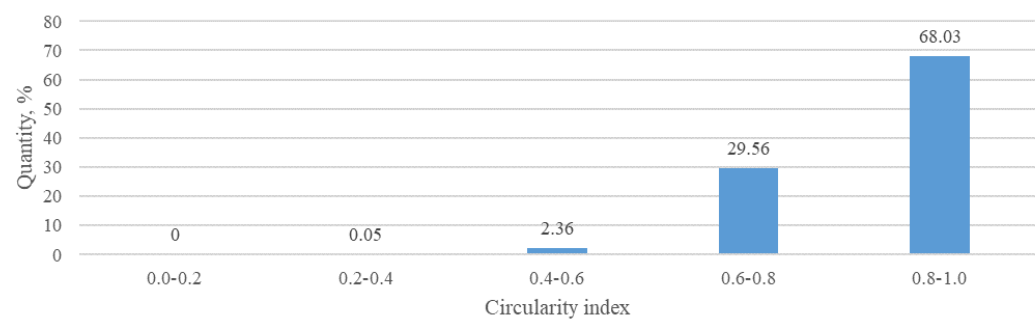
Appl. Sci. 2020 , 10 , x FOR PEER REVIEW Figure 17. Distribution of pellets according to roundness. Figure 17. Distribution of pellets according to roundness. Figure 17. Distribution of pellets according to roundness.